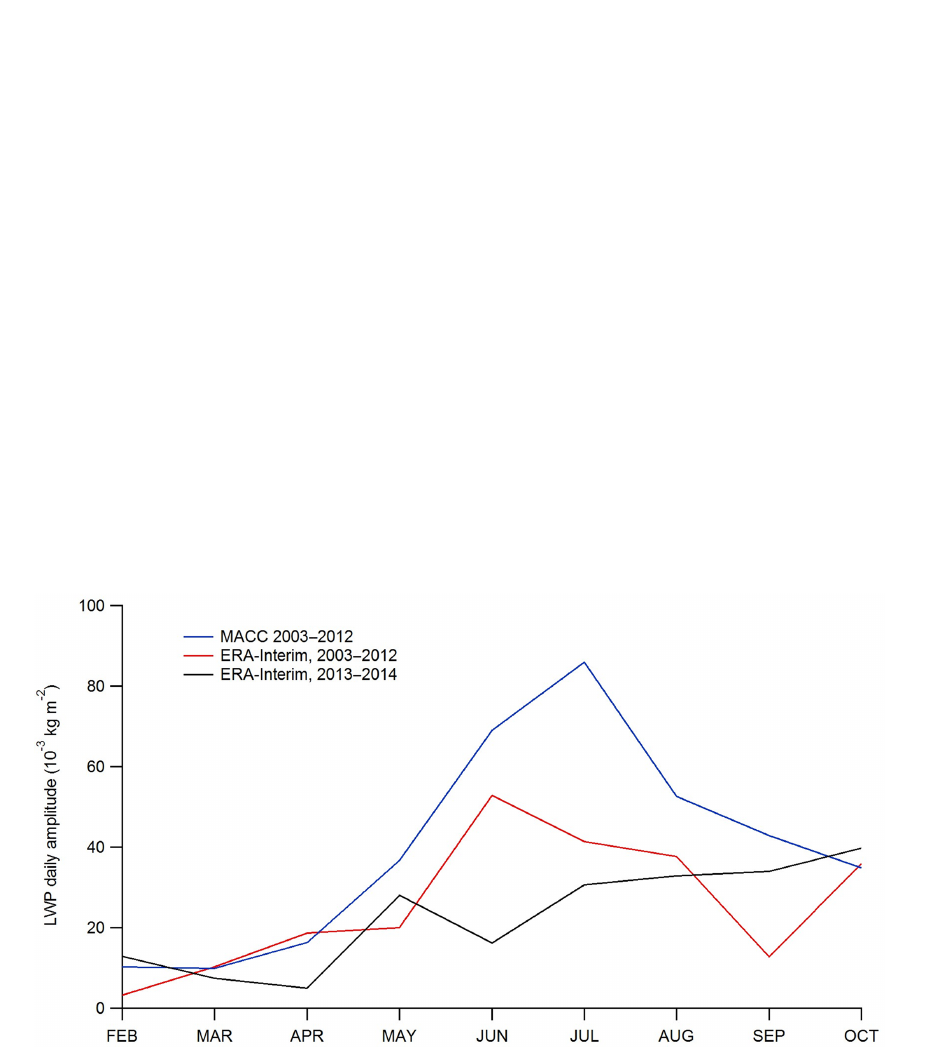
Figure B2. The amplitudes of LWP diurnal variation, calculated as a difference between the maximum and minimum LWP values for each month of the year, derived from the data of reanalysis (MACC 2003–2012, ERA-Interim 2003–2012 and ERA-Interim